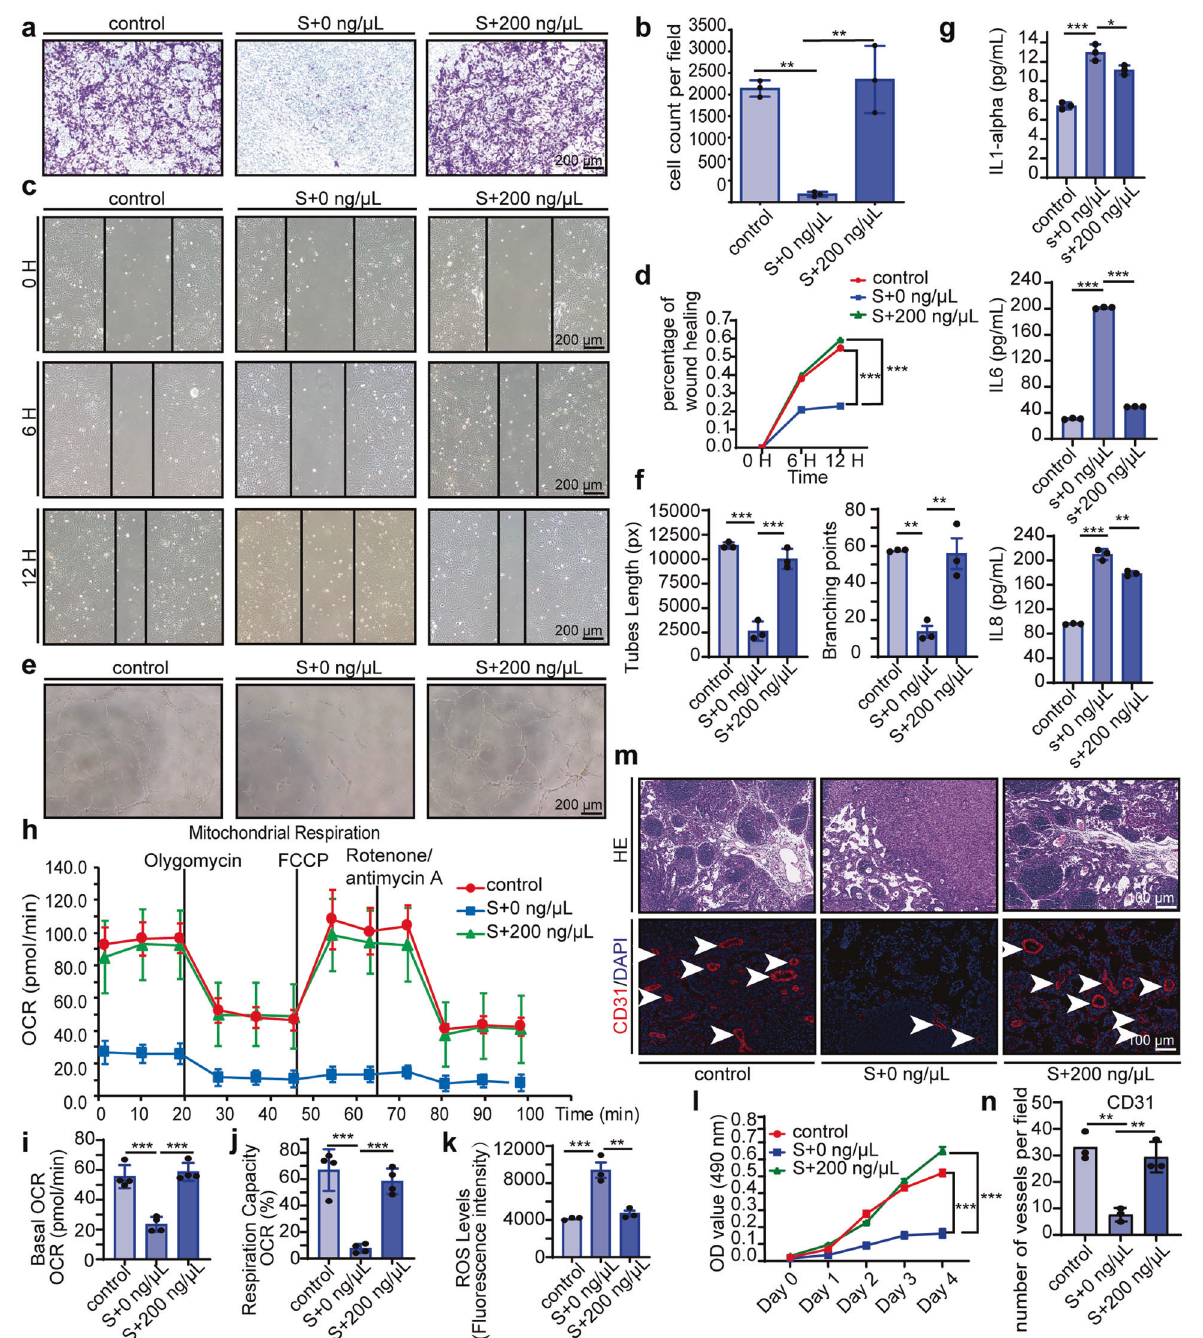
Fig. 3 MSC-sEV rescued senescent HUVECs functions. HUVECs were incubated with (s + 200 ng/ μ L) or without (s + 0 ng/ μ L) MSC-sEV for 48 h after pretreated with H 2 O 2 (50 μ M, 2 h) compared with normal HUVEC (control). a Representative images of transwell migration assays of HUVECs (scale bar, 200 μ m). b Quantitation of transwell migration assays of HUVECs. n = 3, ** p < 0.01, *** p < 0.001. c Representative images wound-healing assay showing the migratory abilities of HUVECs and the image were taken at the indicated times (scale bar, 200 μ m). d Quantitation of wound-healing assay at 12 h. n = 3, *** p < 0.001. e Representative images of in vitro angiogenesis assay (scale bar, 200 μ m). f Quantitation of mean tube lengths and branching points in the HUVEC network. n = 3, ** p < 0.01, *** p < 0.001. g Quantitation of IL-1 alpha, IL-6, and IL-8 released by HUVEC was detected through ELISA. n = 3, * p < 0.05, ** p < 0.01, *** p < 0.001. h Mitochondrial respiratory capacity measured by O 2 consumption rate (OCR) using a Seahorse analyzer. i Quantitation of basal OCR. n = 3, *** p < 0.001. j Quantitation of respiration capacity. n = 3, *** p < 0.001. k Quantitation of the ROS level of HUVEC measured by fl uorometric intracellular ROS Kit on a fl ow cytometer. n = 3, ** p < 0.01. l Quantitation of HUVEC proliferation evaluated by MTS kits with the OD value on Day 0, Day 1, Day 2, Day 3, and Day 4. n = 4, ** p < 0.01, *** p < 0.001. m Representative images of hematoxylin staining and CD31 (red) and DAPI (blue) immuno fl uorescence staining in paraf fi n-embedded sections of Matrigel plugs. n Quantitation of tubes formed in vivo. Arrows indicate tubes formed in vivo. n = 3, ** p < 0.01